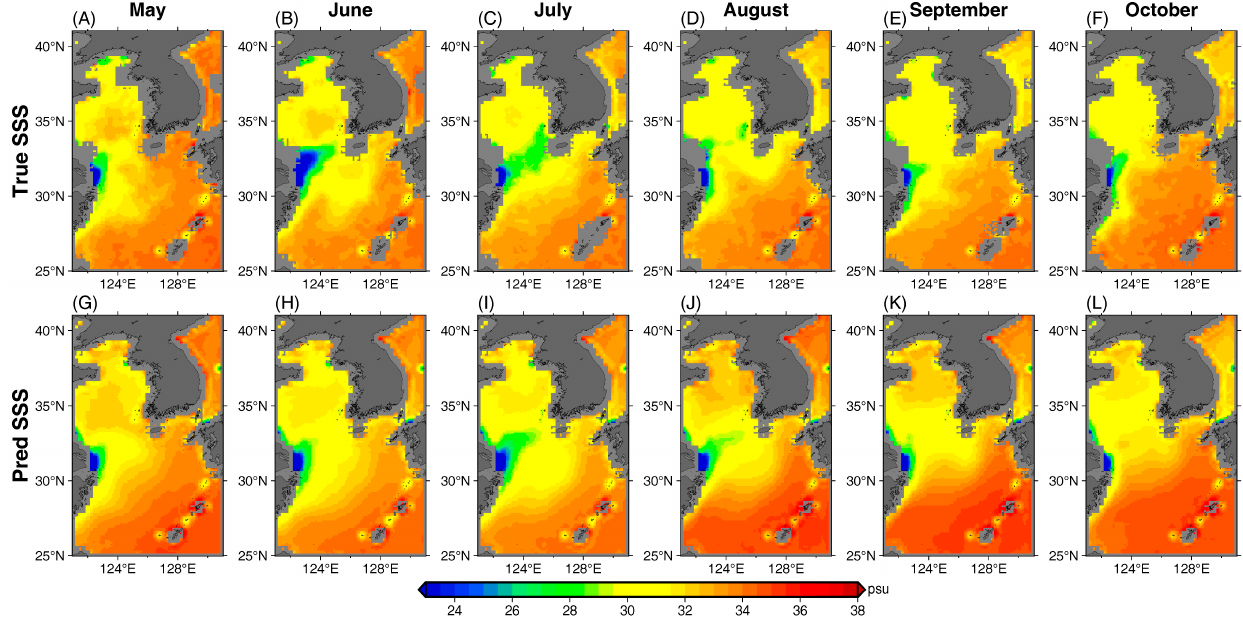
Figure 7. Spatial distributions of true ( A – F ) and predicted ( G – L ) SSSs (Domain 2) for the summer of 2021 over the East China Sea and the Yellow Sea region.